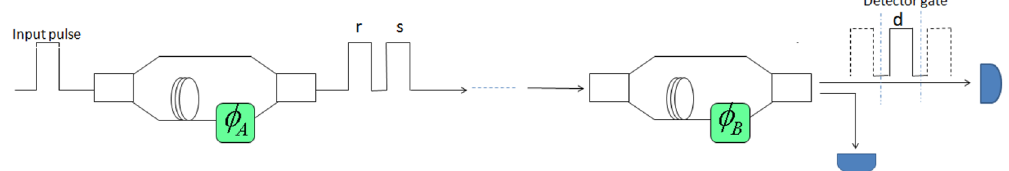
Figure 2. Phase encoded (time-bin) QKD. Alice encodes her key bits by choosing a phase value, φ A , from one of the bases {0, π } and { π /2, 3 π /2}. Each optical pulse passes through the MZI and produces two output pulses with the relative phase φ A . On the Bob side, another MZI is used to recombine r and s modes, followed by photodetection. Active phase and polarization maintenance is assumed to be in